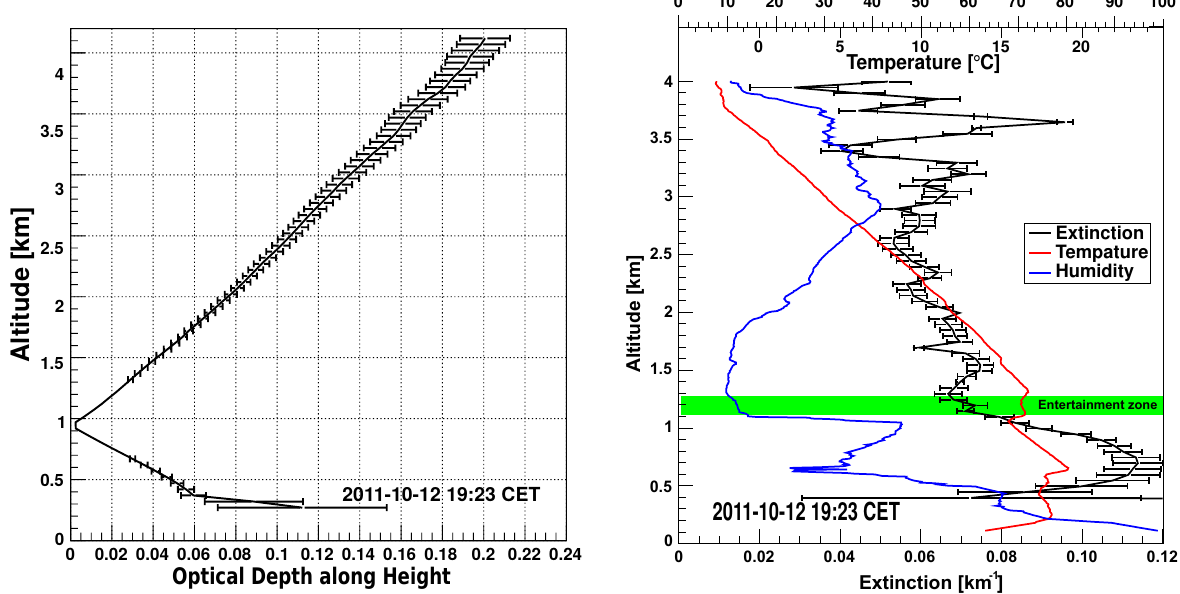
Figure 6. Retrieval results of the aerosol optical depth ( left ) and aerosol extinction ( right ) from the performed spatial scan on 12 October 2011 (Figure 4, bottom). The simultaneously-obtained temperature and humidity profiles from radiosonde measurements at Potoˇce are shown for comparison and the determination of the atmospheric boundary layer height. The green bar shows the entertainment zone determined by the LiDAR and radiosonde joint measurements. Altitude is given relative to the vertical distance above the sea